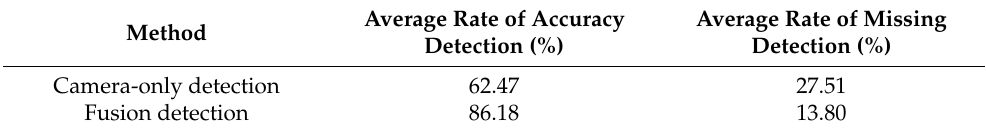
Figure 14. Detection tests in farmland environment. ( a ) Camera-only detection. ( b ) Fusion detection. Table 5. Comparison of single sensor and multi-sensor detection results on all kinds of obstacles. Table 4. Results of the comparison of camera-only detection and fusion